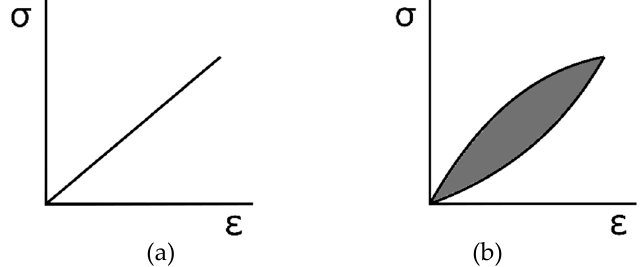
Figure 9. Stress–strain curves of a total elastic ( a ) and visco-elastic ( b ) material with hysteresis and time-dependent behavior.